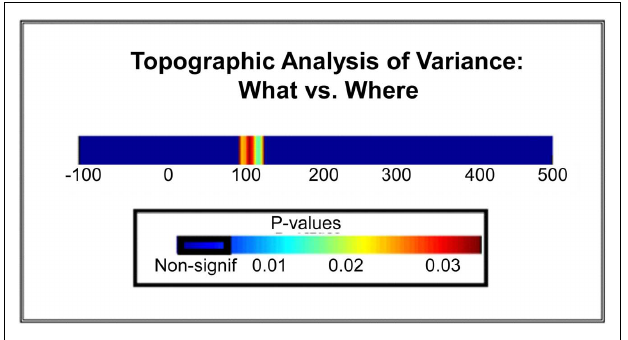
FIGURE 11 | Statistical plot of topographic modulations. Areas of non-significance appear in blue; areas where significance exceeds p < 0.03 are displayed in a graduated color scheme according to the legend shown. Note that this significance cluster falls in a time frame coincident with the N1